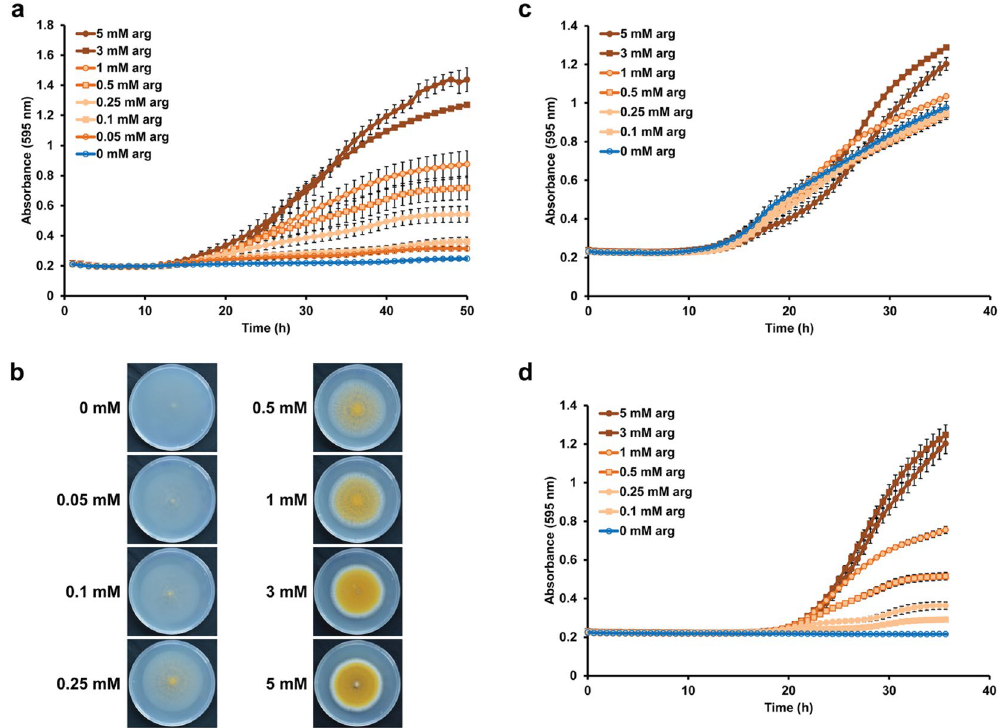
Figure 2. Effects of nutritional conditions or addition of antimicrobials. ( a ) 10 3 spores/mm 2 of the wild-type strain were inoculated in the wells containing solid minimal media with concentrations of arginine ranging from 0 to 5 mM. Arginine was employed as the sole nitrogen source in this experiment. ( b ) Conventional growth test of A . nidulans wild type on different concentrations of arginine as sole nitrogen source. Radial growth using solid media on petri dishes was the same regardless of the arginine concentration.